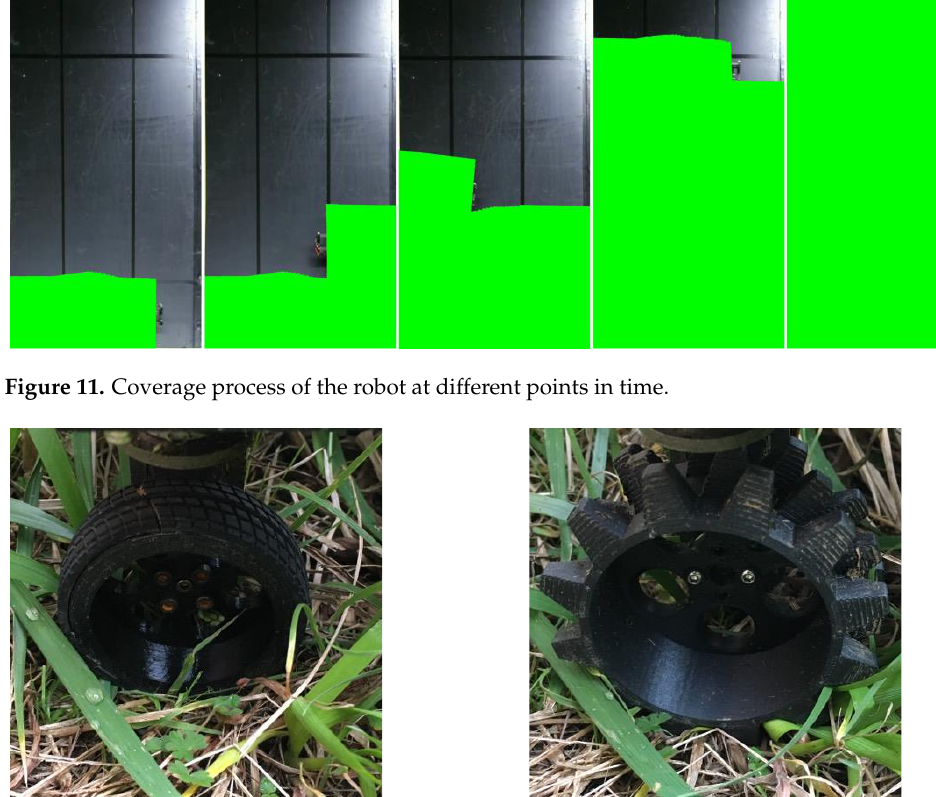
Figure 13. Straight movement experiment on grassy terrain in a mountainous area.